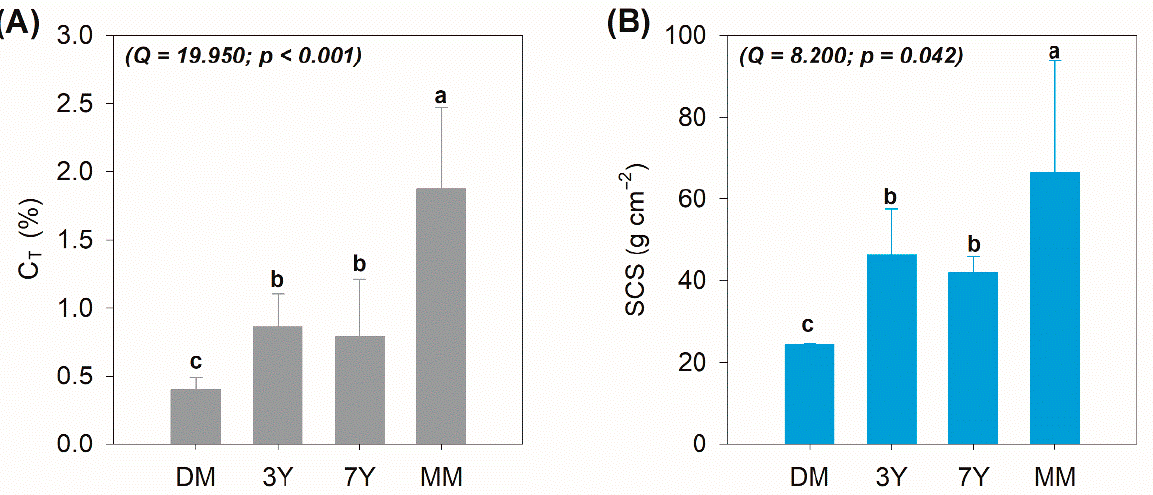
Figure 3. ( A ) Total organic carbon (C T ) contents and ( B ) soil carbon stocks (SCSs). DM: degraded mangrove, 3Y: mangroves with 3 years of planting, 7Y: mangroves with 7 years of planting, MM: mature mangrove forest. The different lowercase letters on the bars indicate a significant difference between the variables as determined by the Friedman test at a 5% probability level as Q values above the critical Q (7.8147) indicate statistical differences.